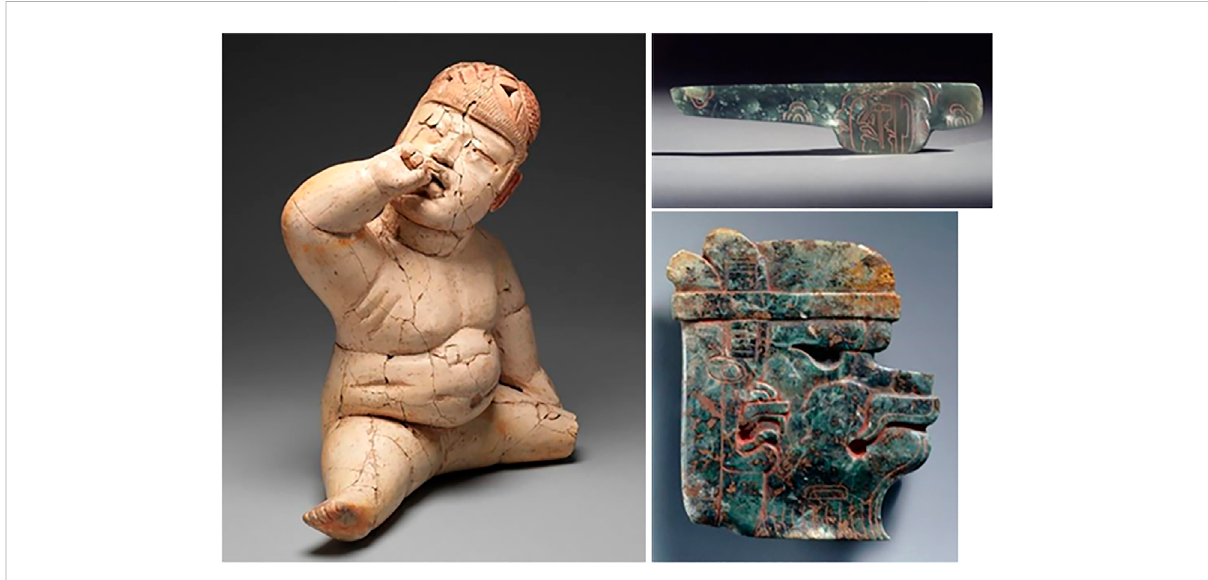
FIGURE 1 Archaeological evidence of early (before c.500 BCE) cinnabar (HgS) use in Mesoamerica. Left: “ Hollow-baby ” an EarlyFormative(?) period Olmec seated fi guredecoratedwithcinnabarpowder(CourtesyMetropolitanMuseumofArt,MichaelC.RockefellerMemorialCollection,BequestofNelsonA. Rockefeller,1979,no.1979.206.1134).TopRight:Olmec “ spoon ” injadewithcinnabarinincisedlines(CourtesyoftheBrooklynMuseum).BottomRight: Middle Formative (c. 1,000 – 500 BCE) Olmec jade pendant with cinnabar with cinnabar in incised lines. Source: “ Plaque, 1996-11, ” Princeton University Art Museums collections online, 10 April 2022, https://artmuseum.princeton.edu/collections/objects/44888.